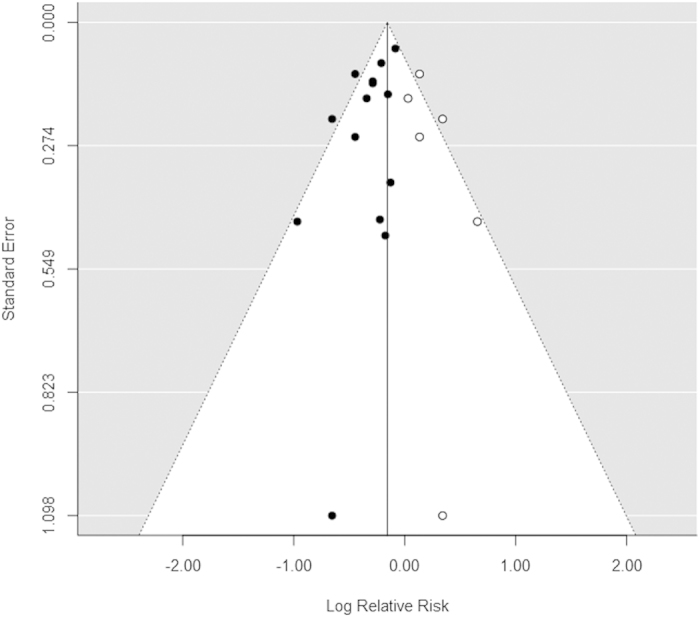
Filled funnel plot of total coffee intake and relative risk of EC.